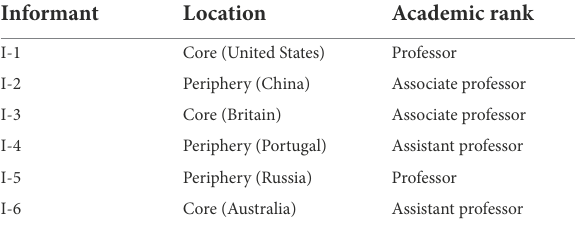
TABLE 2 Demographic information of participants for the